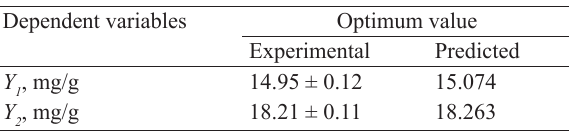
Table 6 Predicted response values and experimental response values obtained under optimum conditions